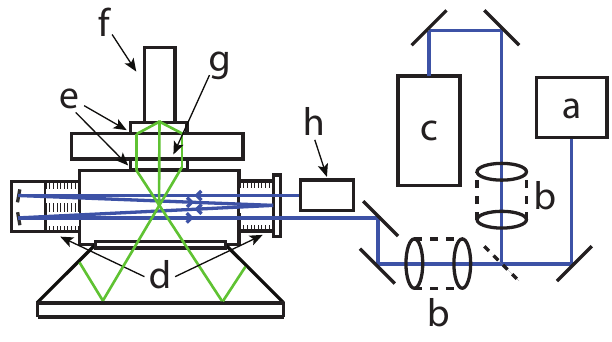
Fig. 1. Schematic drawing of the experimental setup. The compo- nents are: light source (a) , focusing optics (b) , cavity ringdown cell (c) , light baffles (d) , collimating optics (e) , single photon counter photomultiplier tube (f) , optical bandpass filter (g) , laser power meter (h) . Components (d–g) are inside the white type multipass cell. A pump (not shown) draws air through the detection cell at ∼